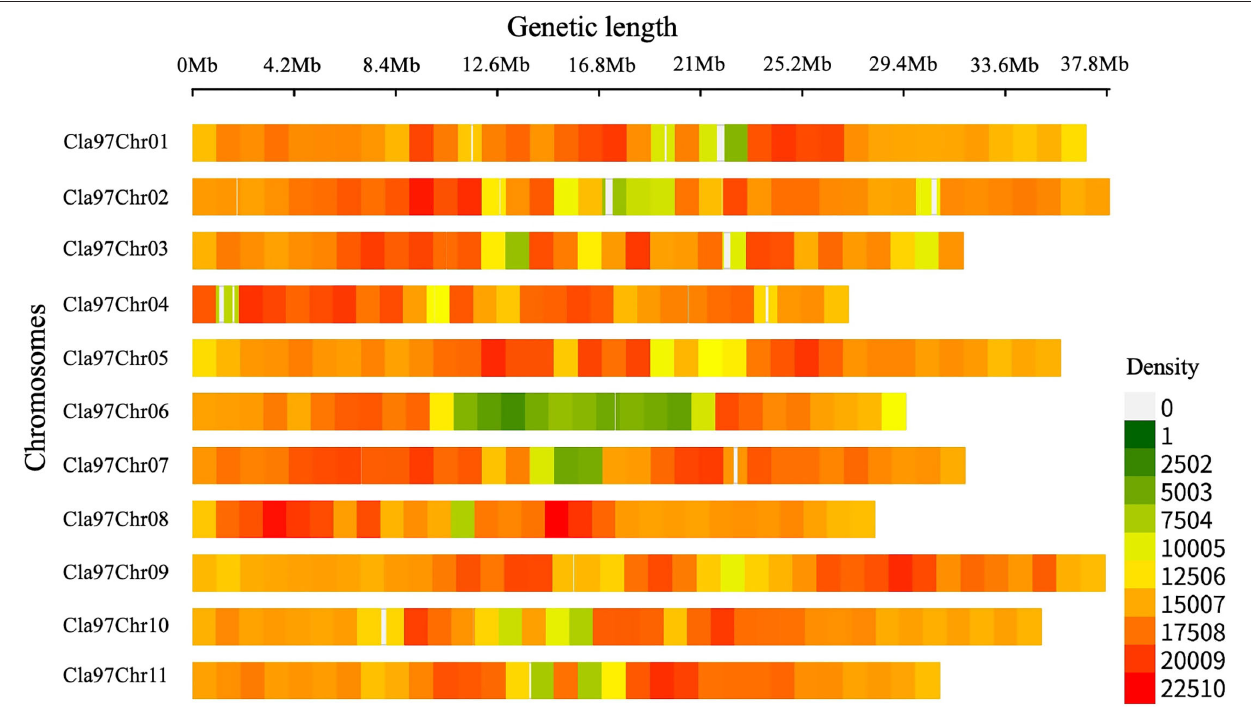
chromosome by their proper physical positions (bp), fragment product lengths, and endonuclease sites ( Figure 5